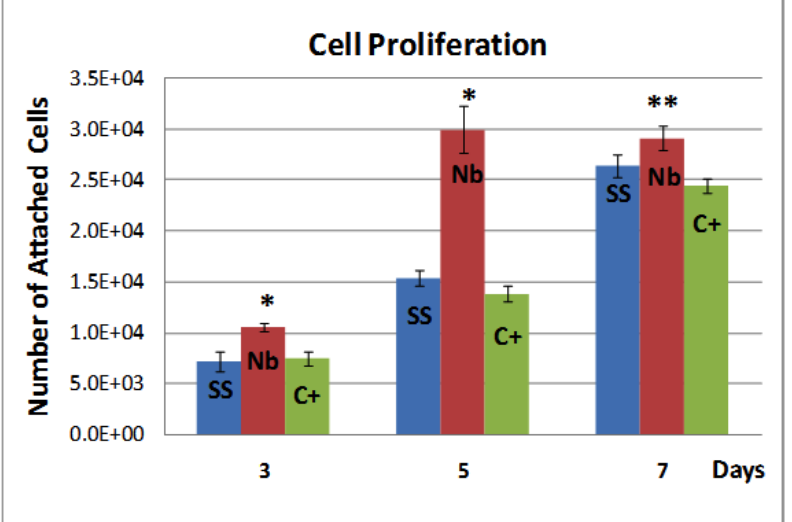
Figure 6. Number of cells as a function of the culture time. The initial number of plated cells was 2 x 10 4 cells/sample, since this number was the same for all surfaces, it can be concluded that Nb promoted the greatest proliferation over the three surfaces at days 3 and 5 (* p < 0.01 and ** p <